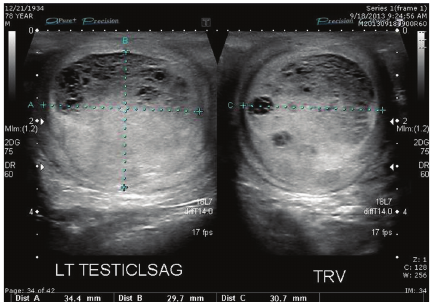
Figure 1: Scrotal ultrasound of left testis (sagittal and transverse views). Note the cystic and solid lesion of mixed echogenicity.